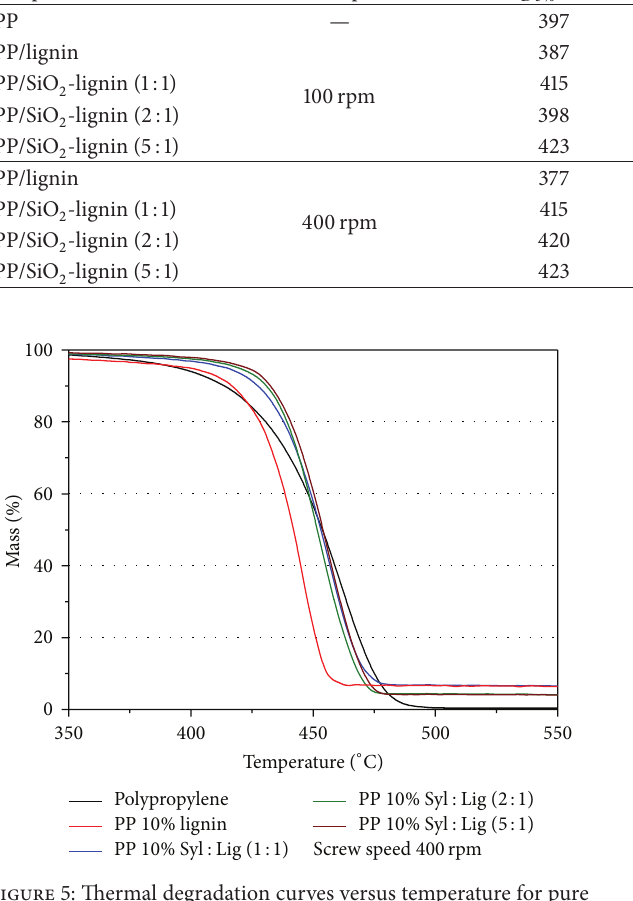
Figure 6: Thermal degradation curves versus temperature for pure PP and its blends with lignin after extrusion with 100 and 400rpm of screw